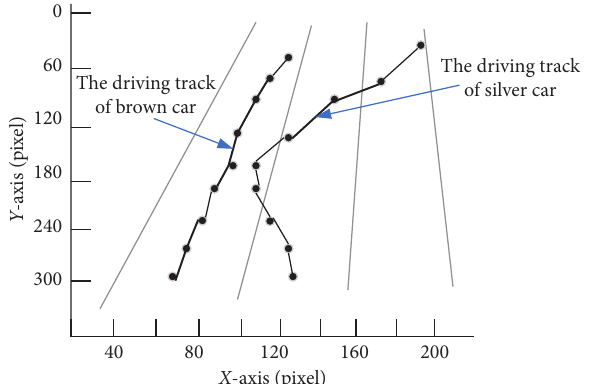
Figure 12: The brown car driving trajectory diagram and the silver car driving trajectory diagram in the